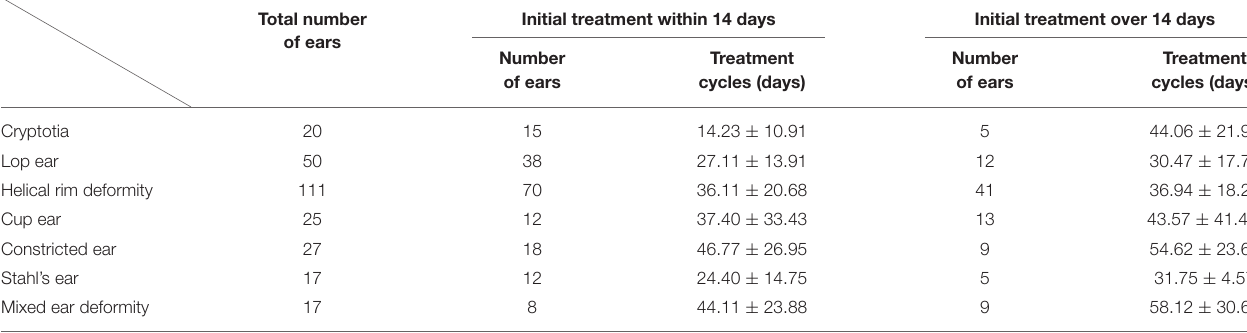
TABLE 3 | The treatment cycles of different malformations in different age groups (x ± s,